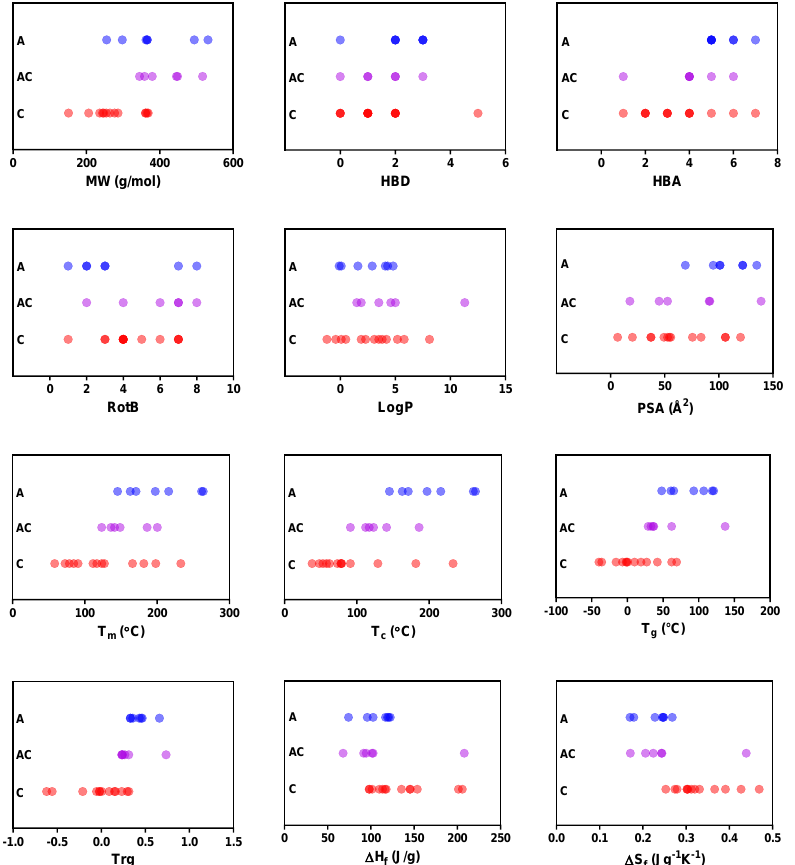
Figure 6. Univariate analysis of the relationships between the glass-forming ability of the compounds upon spray-drying and selected physicochemical properties. The physicochemical properties presented are molecular weight (MW), number of hydrogen bond donors (HBD), number of hydrogen bond acceptors (HBA), number of rotatable bonds (RotB), logP, polar surface area (PSA), melting point (T m ), crystallization temperature (T c ), glass transition temperature (T g ), reduced glass transition temperature (T rg ), heat of fusion (ΔH f ), and entropy of fusion (ΔS f ). The compounds are categorized as fully amorphous (A), a mixture of amorphous and crystalline (AC) or fully crystalline (C).